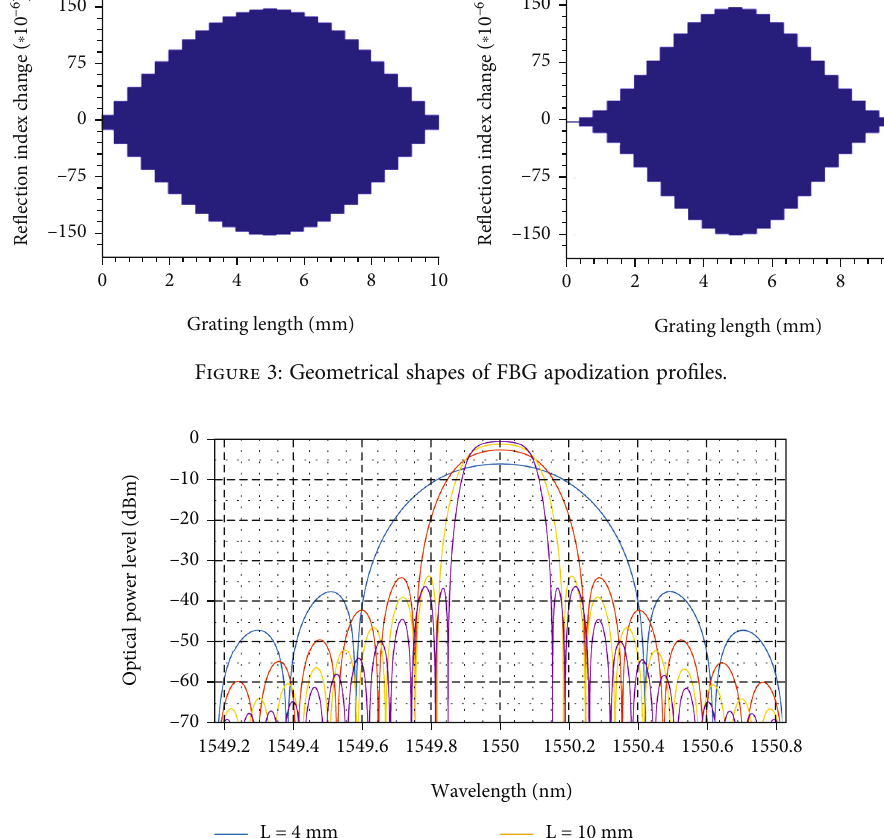
Figure 4: Re fl ected signal spectra of the FBG with raised sine apodization ( Δ n = 1 : 5 × 10 − 4 ) and various grating